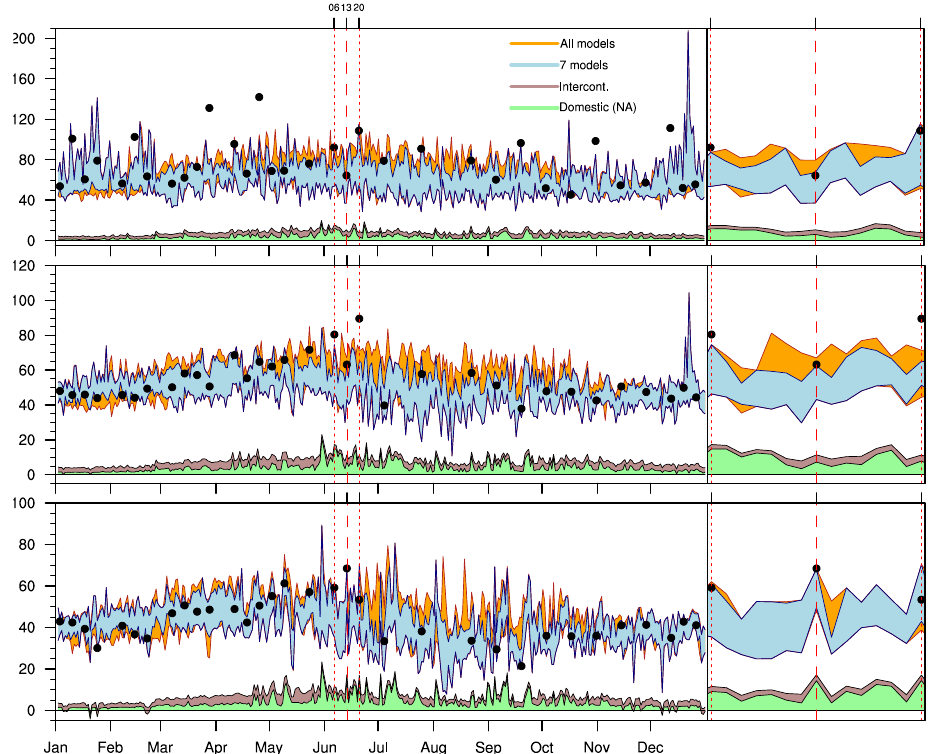
Fig. 7: Daily range of noon ozone levels in ppb and stacked from intercontinental (EU, EA and SA) and domestic (NA) contributions for Goose Bay in the UT (500 - 300hPa) top, MT (700 - 500hPa) middle and LT (900 - 700hPa) bottom panel. The focused panels on the right hand side are centred around the June 13. episode, highlighted in Section 4.1.1 and bounded by red lines in the Figure. The range for the first seven models listed in Table 1 are shown in blue. The additional range, including all models in Table 1, are shown in orange. Ozone measurements from ozonesondes are marked as black dots. The model mean stacked contributions (multipl. by 5) from domestic (NA) and intercontinental (EU, EA and SA) are also shown.